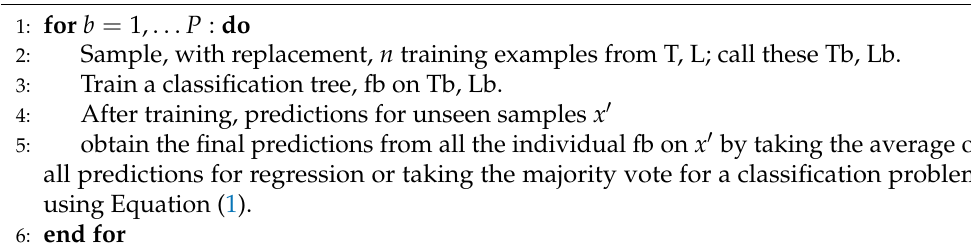
Algorithm 1 The algorithm for bagging